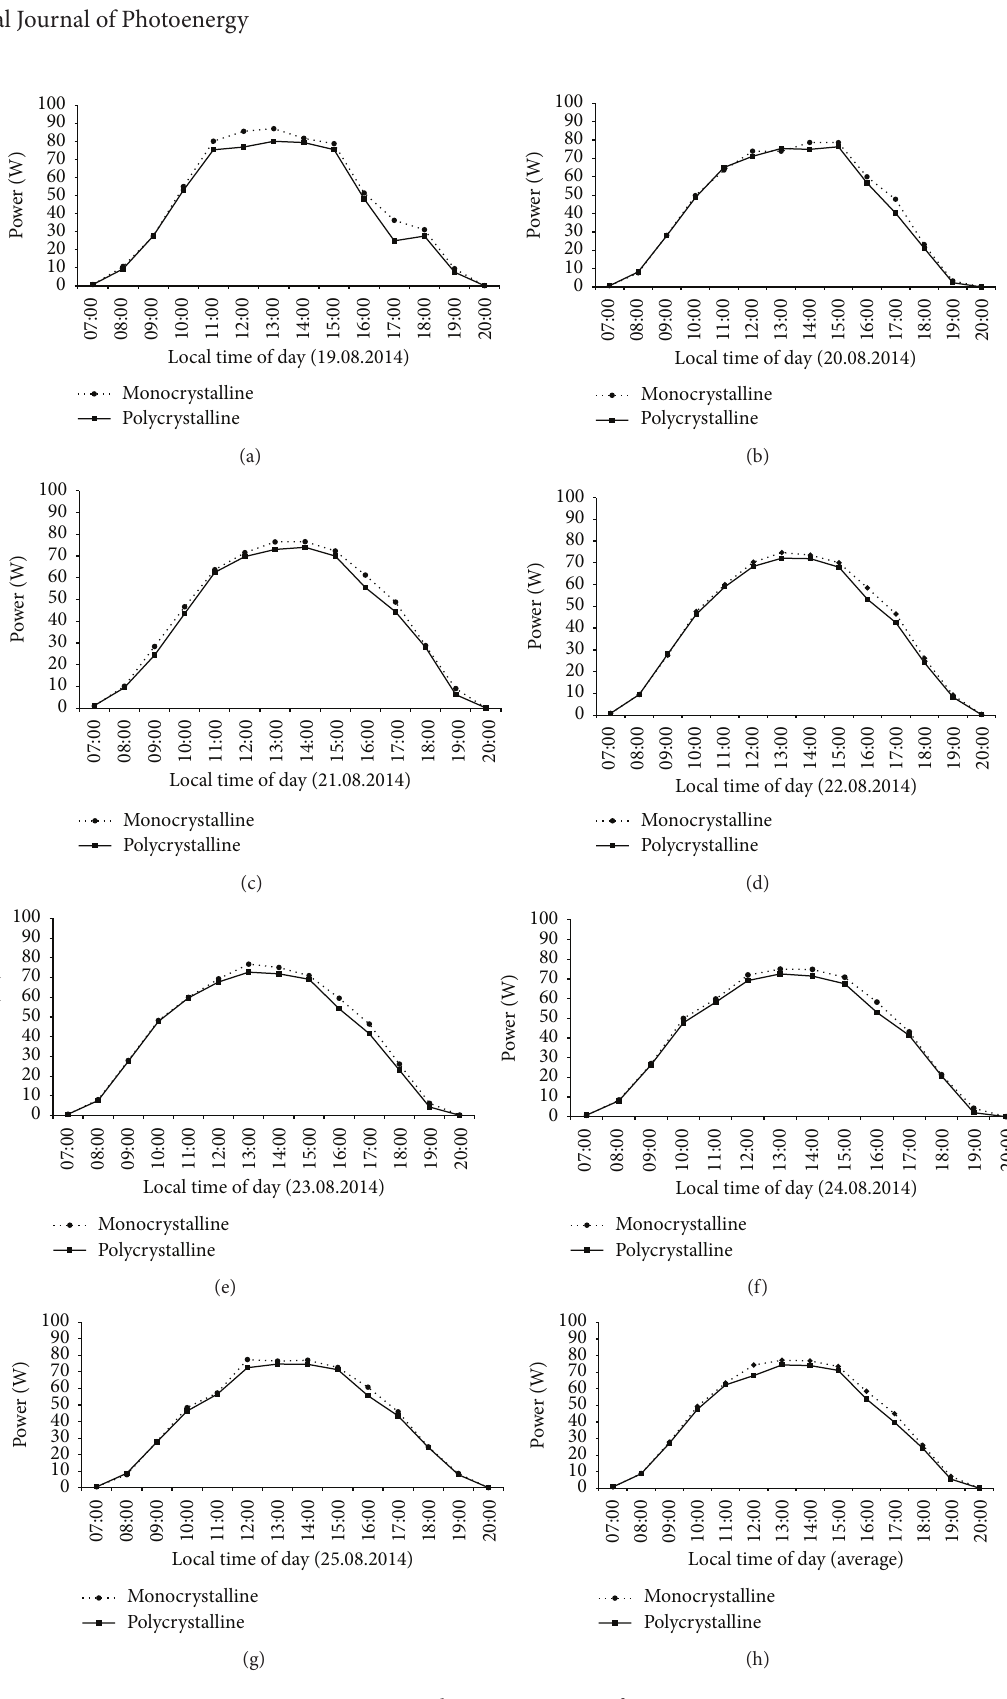
Figure 5: Hourly power output